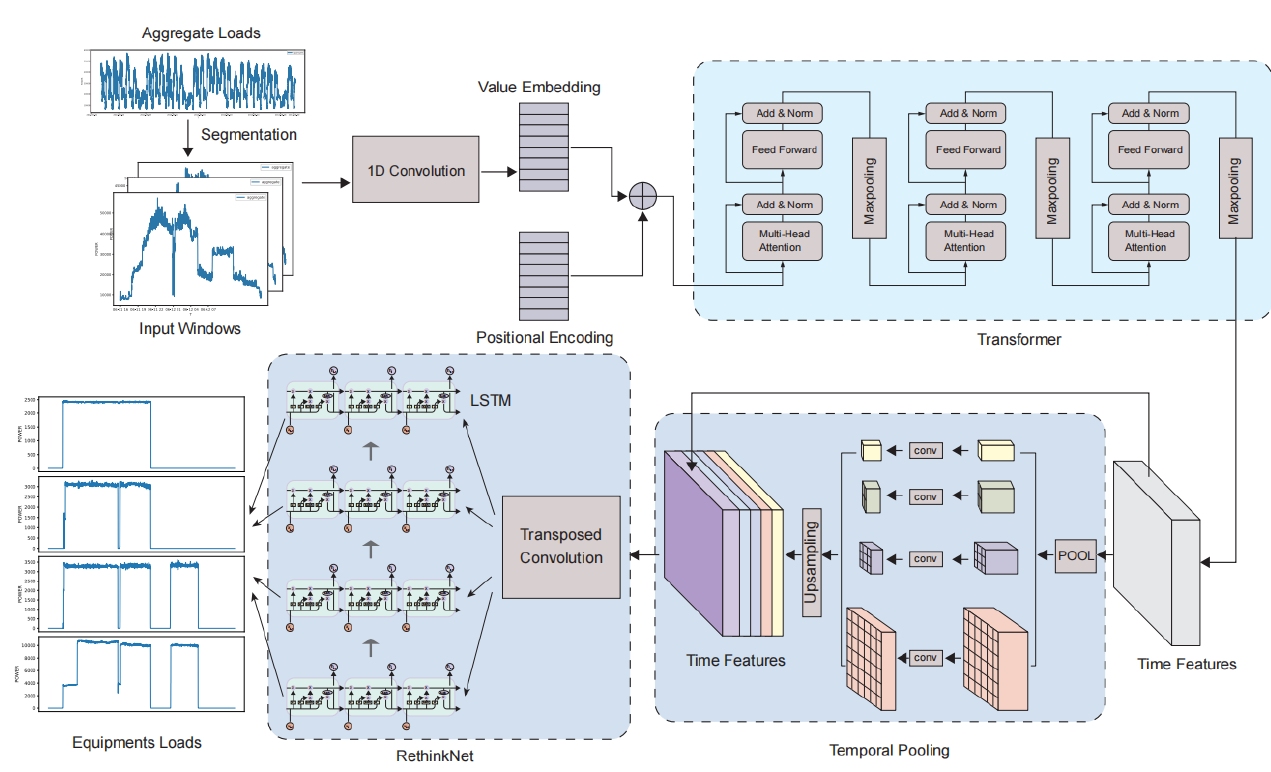
Figure 1. The TTRNet model